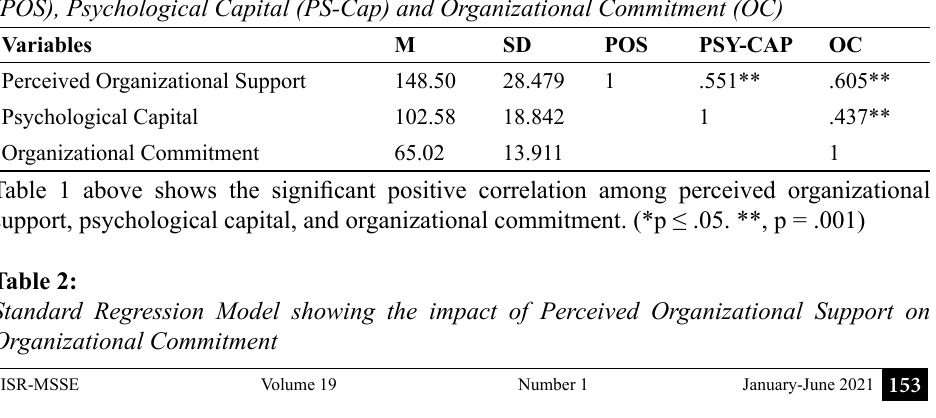
Standard Regression Model showing the impact of Perceived Organizational Support on Organizational